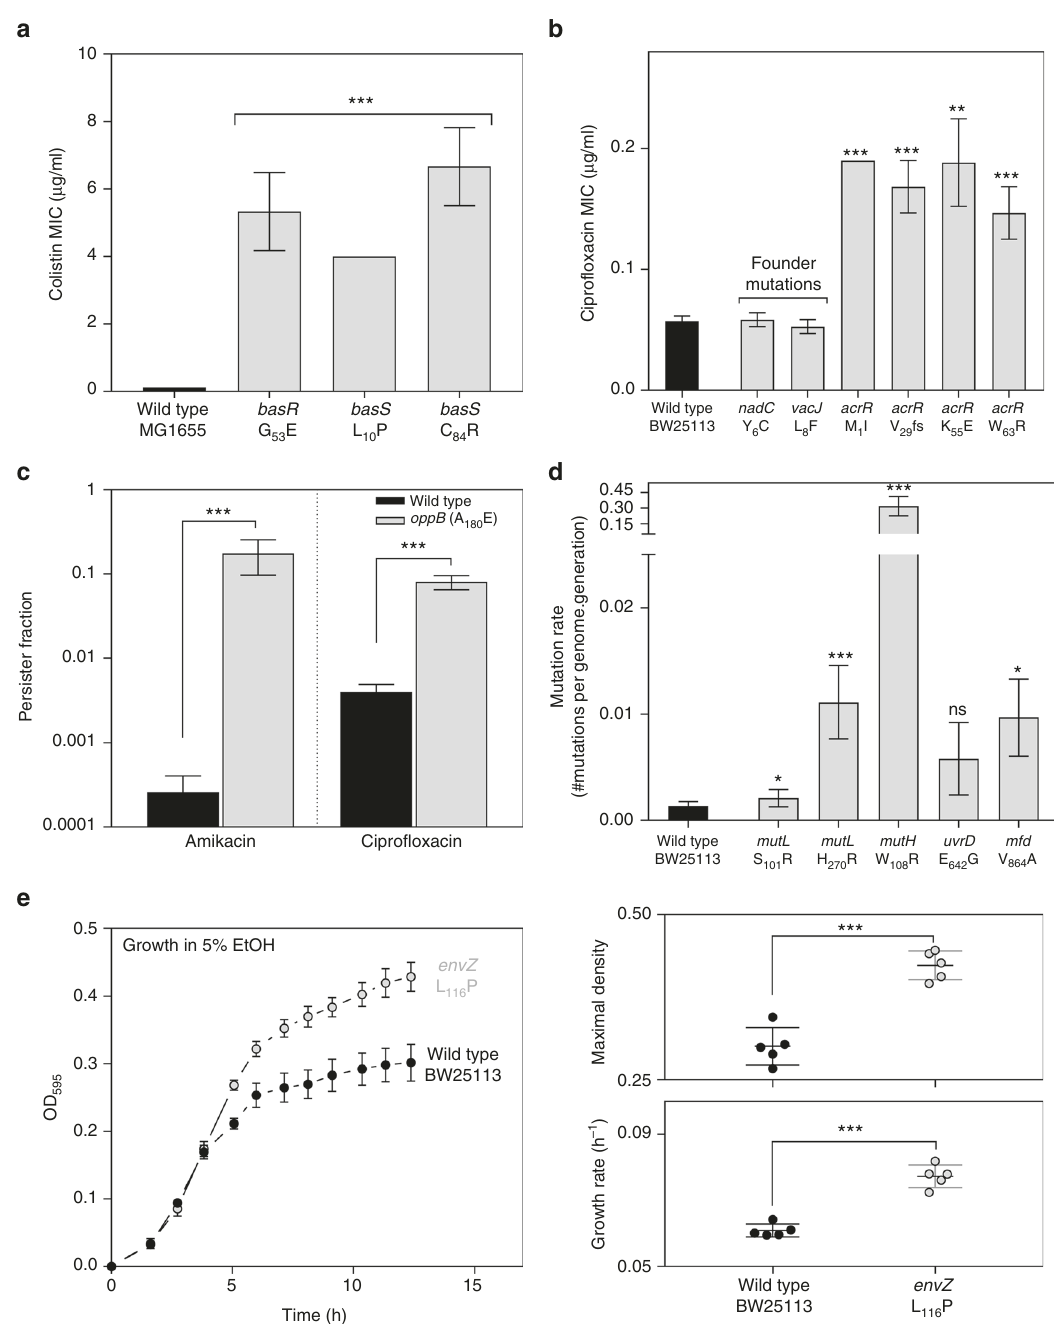
Fig. 3 CRISPR-FRT allows rapid reconstruction and phenotypic characterization of generated mutants. a Mean colistin minimum inhibitory concentrations (MIC) for wild-type MG1655 and otherwise isogenic basR and basS mutants ( n = 3; error bars represent the s.d.; two-sample unpaired t-test; *** p < 0.001 vs. wild type). b Mean cipro fl oxacin minimum inhibitory concentrations (MIC) for wild-type BW25113 and otherwise isogenic nadC , vacJ and acrR mutants ( n ≥ 3; error bars represent standard error of the mean; two-sample unpaired t-test ** p < 0.01, *** p < 0.001 vs. wild type). c When treated with amikacin or cipro fl oxacin the oppB (A 180 E) mutant shows a signi fi cantly increased surviving persister fraction compared to the wild type ( n = 3; error bars represent the s.d.; two-sided t-test; *** p < 0.001). d Mutations in mutL , mutH , uvrD and mfd can change the genomic mutation rate. While all mutants show a higher mutation rate, only the mutL (S 101 R), mutL (H 270 R), mutH (W 106 R) and mfd (V 864 A) mutants show a signi fi cantly higher mutation rate compared to the wild type ( n = 24; error bars represent upper and lower limits of the 95% con fi dence intervals; ShinyFlan R package built-in two-sample comparison [30]; * p < 0.05; *** p < 0.001). e The envZ (L 116 P) mutant exhibits enhanced growth characteristics in the presence of 5% (v/v) ethanol compared to the wild type (left panel). Both the maximal fi nal density (right top panel) and the growth rate (right bottom panel) signi fi cantly improved compared to the wild type ( n = 5; error bars represent s.d.; unpaired two-sided t-test; *** p < 0.001). n.s. non-signi fi